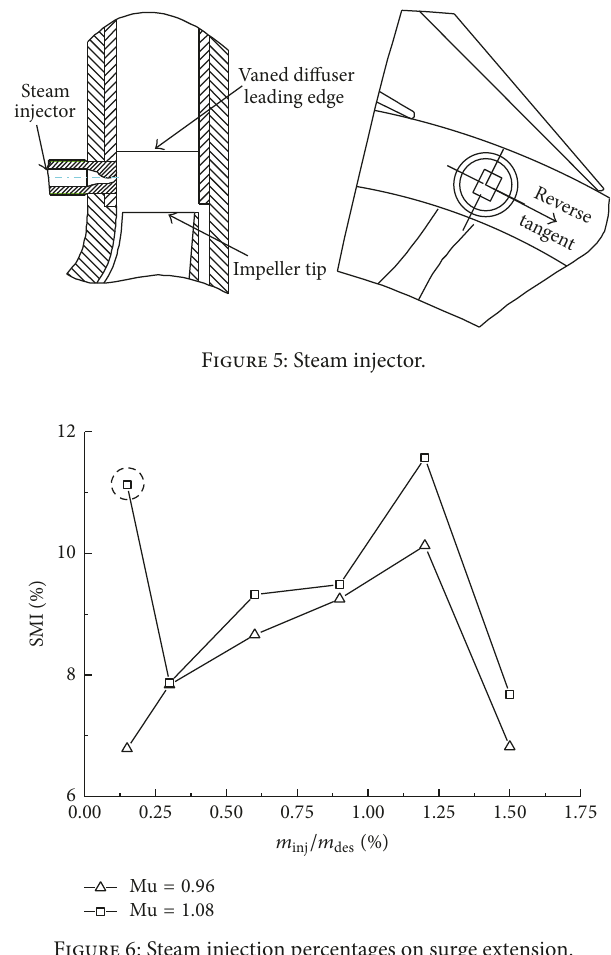
Figure 6: Steam injection percentages on surge extension.